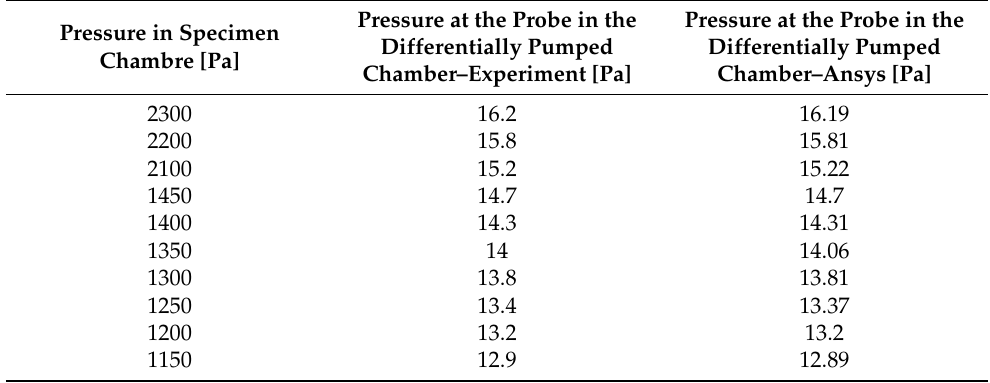
Table 1. Comparison of values obtained by experimental measurements with results obtained by Ansys Fluent analyses.